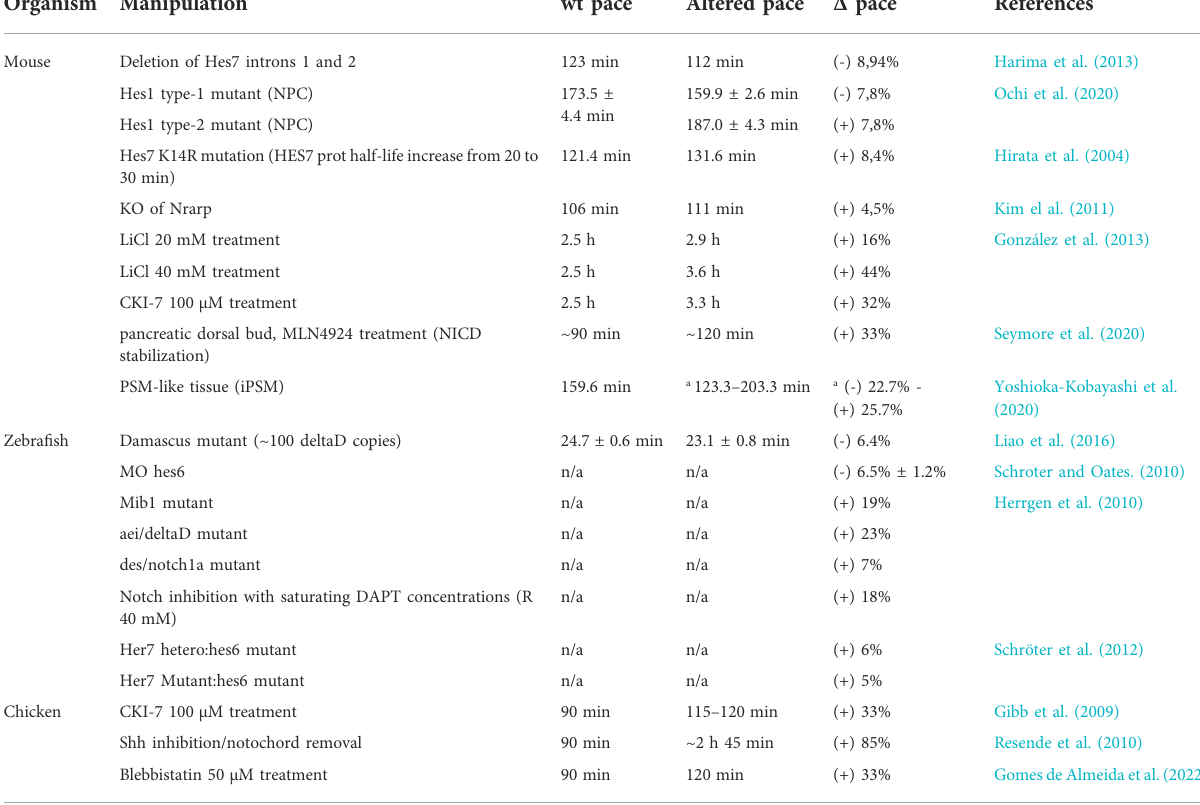
TABLE 5 Embryo Clock pace manipulation. Organism